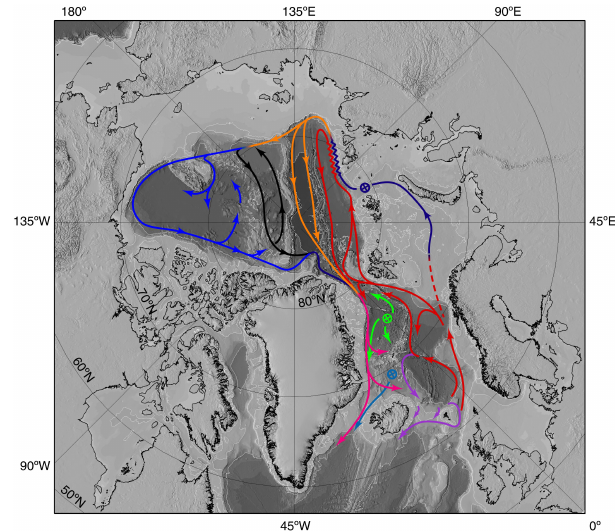
Fig. 11. Circulation of the Atlantic and intermediate waters in the Arctic Mediterranean Sea showing the mixing area north of Sever- naya Zemlya and the gradual changes of the properties of the At- lantic water. Based on Rudels et al. (1994), figure from Rudels et al.